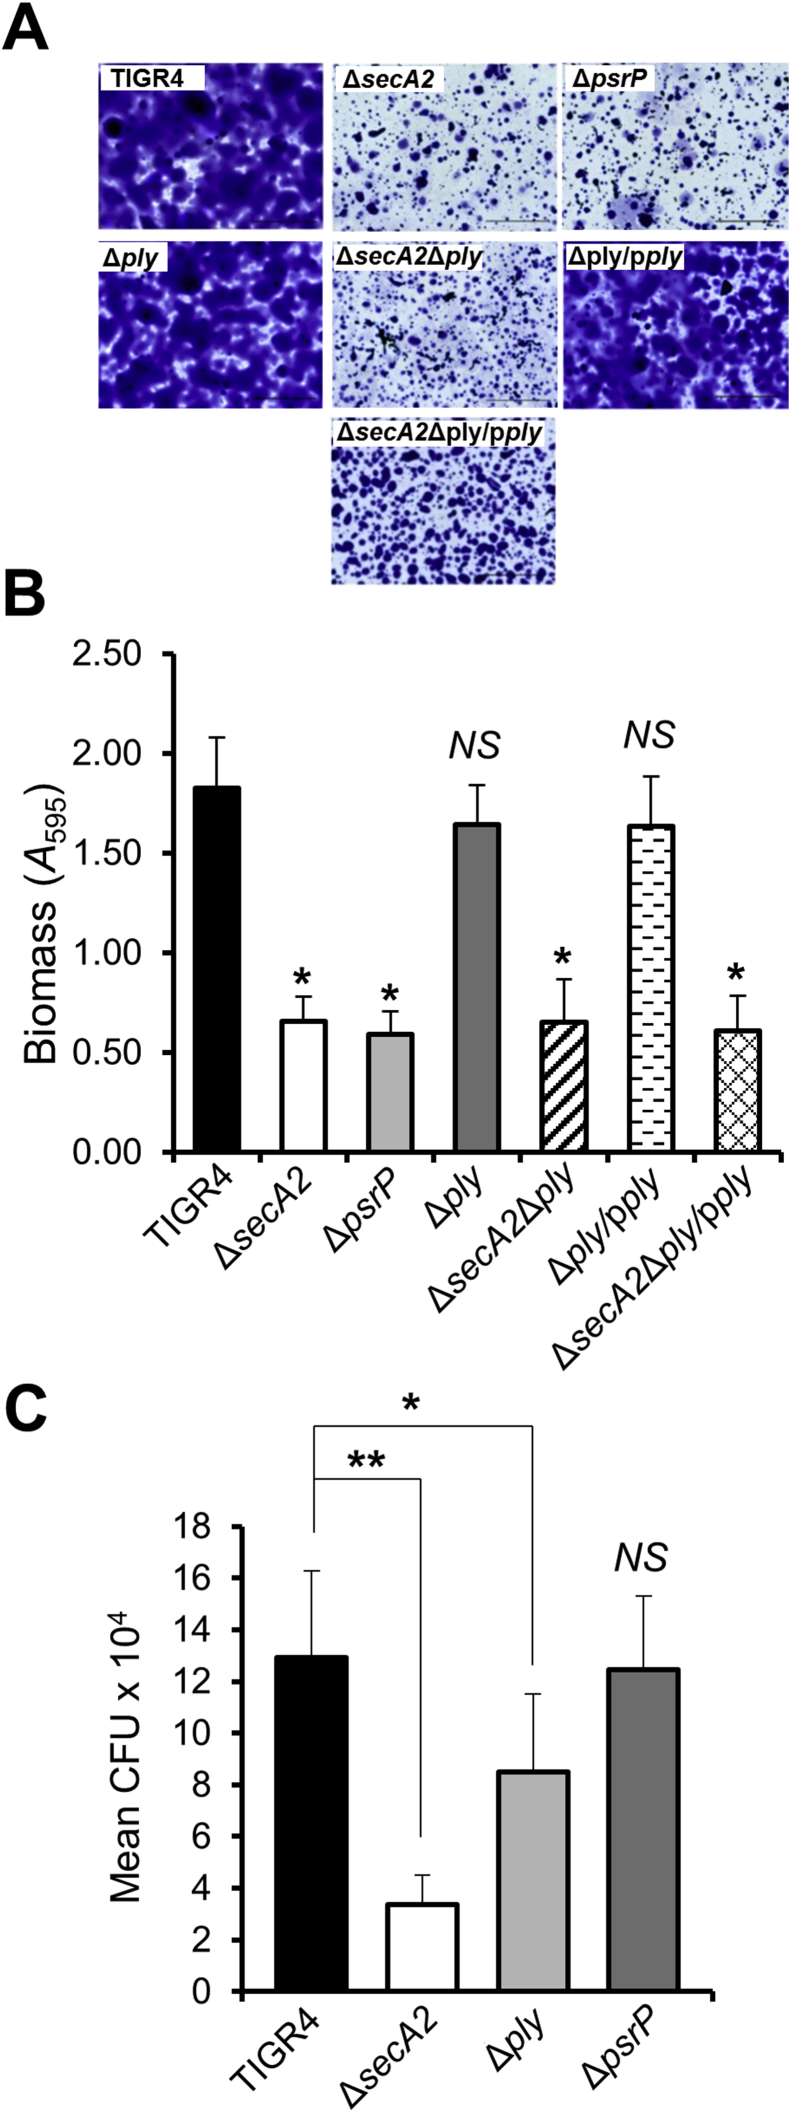
Biofilm formation and association to lung cells by S. pneumoniae TIGR4, mutants and ply complemented strains. (A) Representative light micrographs of corresponding S. pneumoniae biofilms grown at 6 h and stained with crystal violet. Scale bar = 50 μm. (B) S. pneumoniae monospecies biofilms were grown on saliva coated cover slips for 6 h at 37 °C. Total biomass was quantified by crystal violet staining as described in Materials and Methods. Statistical significance compared to the wild type TIGR4 is indicated by an asterisk (*P < 0.05). No statistical significant difference from the wild type (NS) is also indicated. (n = 3). (C) S. pneumoniae association with A549 epithelial cells. A549 cells were grown to a confluence of 2 × 105 cells and infected with S. pneumoniae TIGR4 and mutant strains (1 × 106 cells ml−1 input) for 2 h at 37 °C. After removal of non-associated bacteria and washing of the epithelial cells, the numbers of bacterial cells associated with A549 cells were determined (CFU) by agar plate counts. P values: * <0.1, ** <0.05. No statistical significance to the wild type (NS) is also indicated. (n = 2).